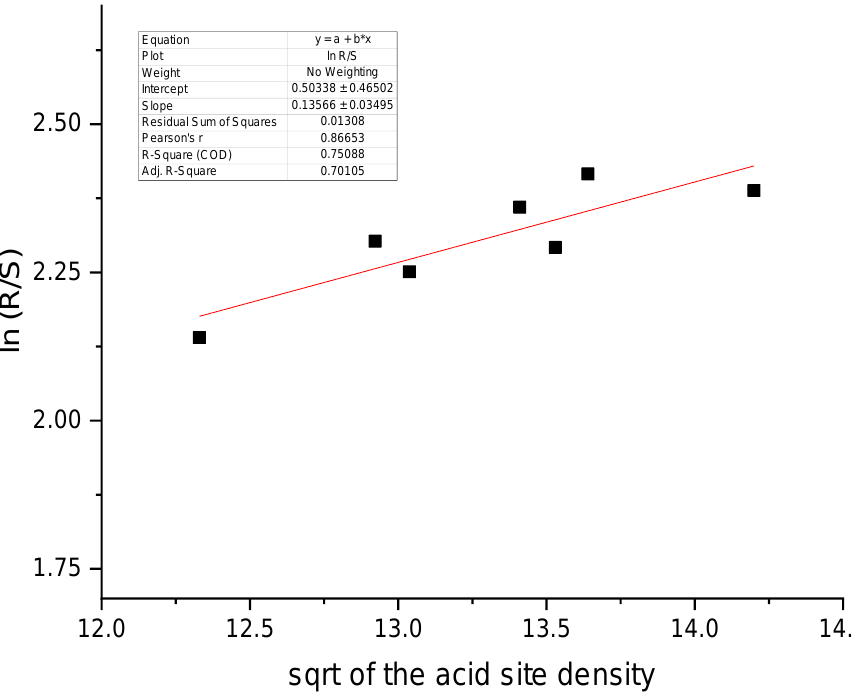
) and ( α − α ) ϕ (cid:48) are respectively / k + 2 C A 2 3 3 2